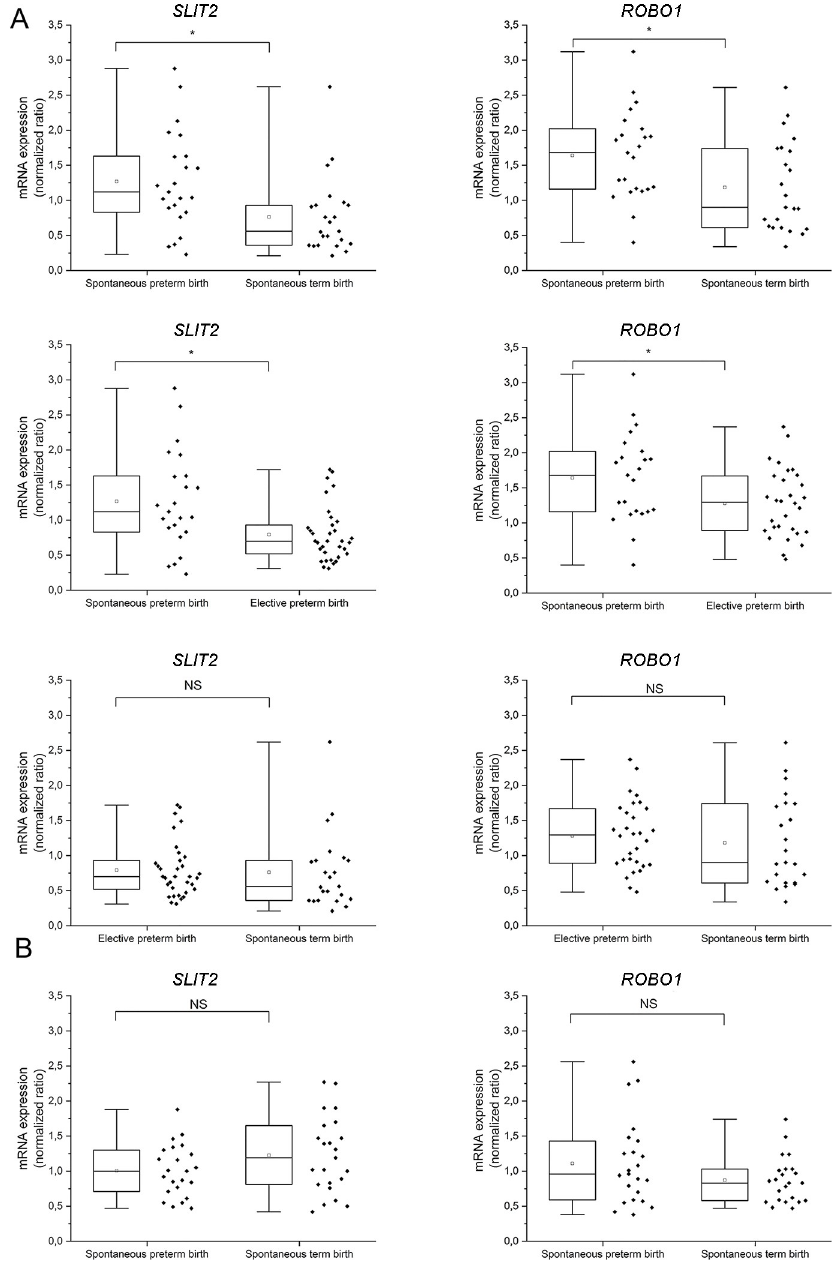
Fig 4. mRNA levels of SLIT2 and ROBO1 in spontaneous preterm, spontaneous term, and elective term placentas. Relative mRNA levels from the basal (A) or chorionic (B) plates were normalized to mRNA levels of the housekeeping gene CYC1 . Differences were analyzed with nonparametric Mann–Whitney U -test. Asterisk indicates statistically significant changes. Box and whiskers display quartiles. Band inside the box is the median, and ends of whiskers show the minimum and maximum values; square inside the box represents the mean